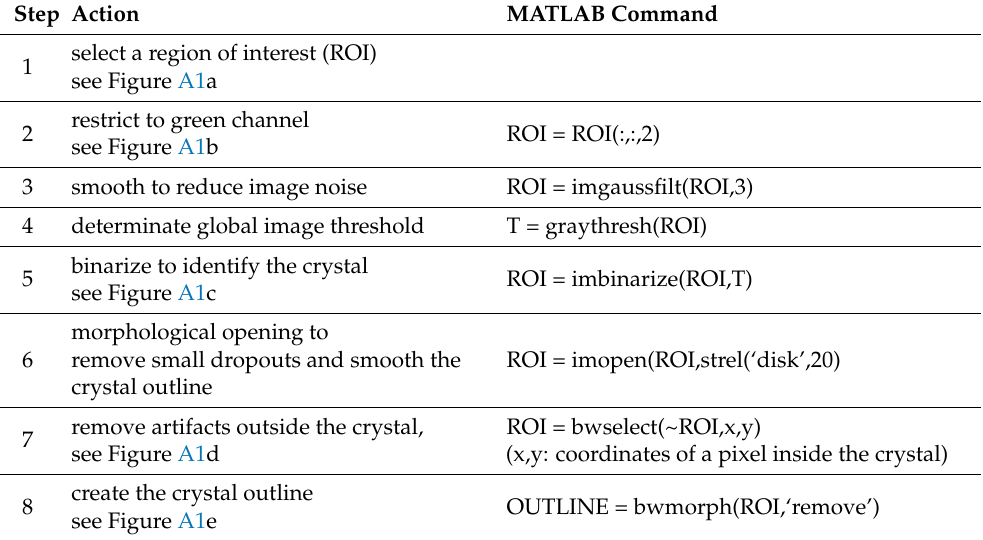
Table A3. Image processing procedure to find the crystal outline.